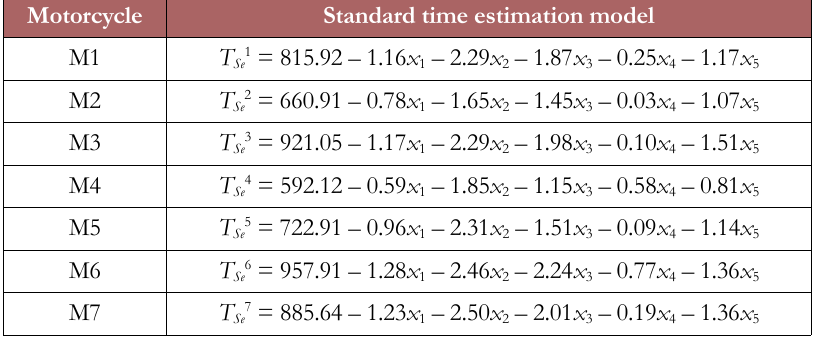
Table 7. Multiple linear regression models for the front of motorcycles